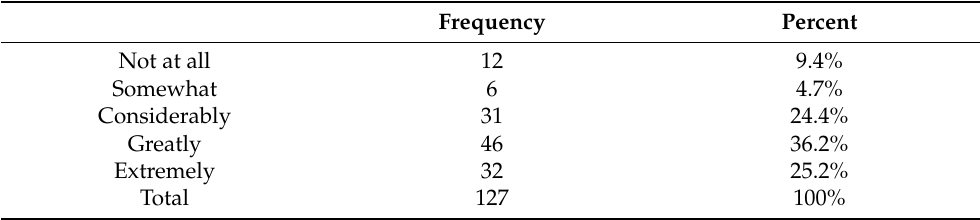
Table 4. Importance of Compensation and Benefits Package in employees’ job satisfaction.